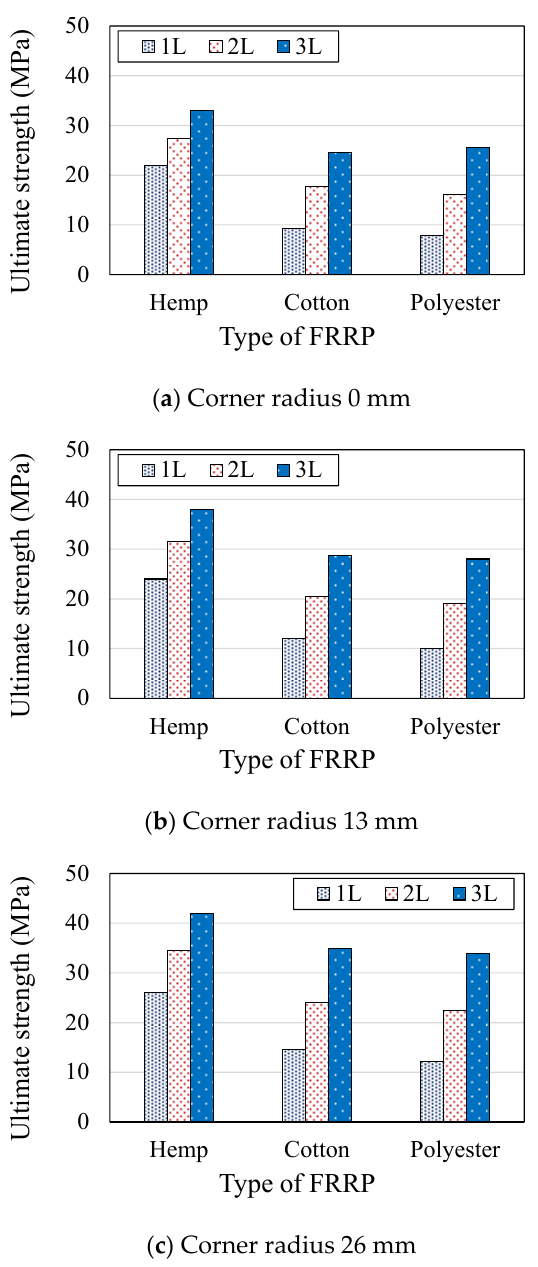
Figure 11. Effects of fiber ropes on ultimate strength (1L = 1 layer of FRRP, 2L = 2 layers of FRRP, 3L = 3 layers of FRRP).